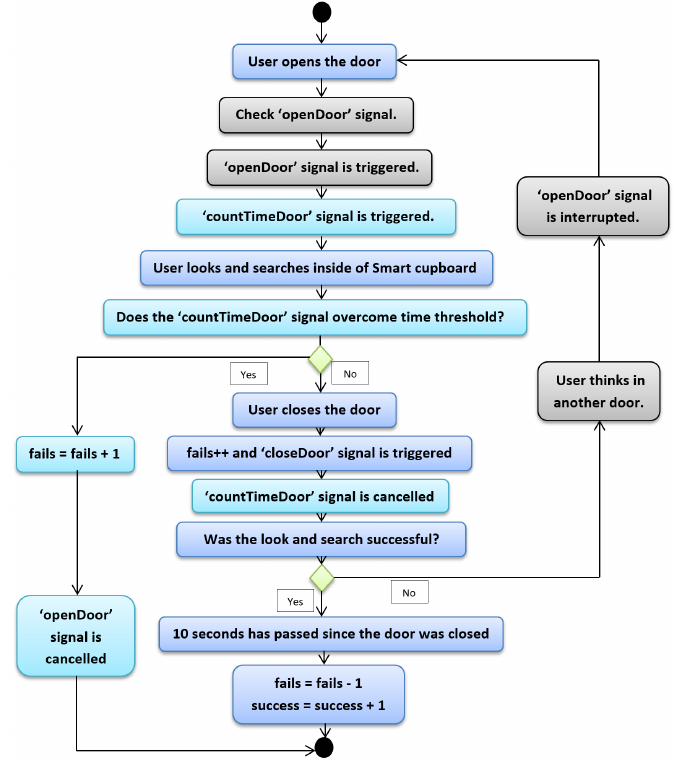
Figure 6. Python script—Third